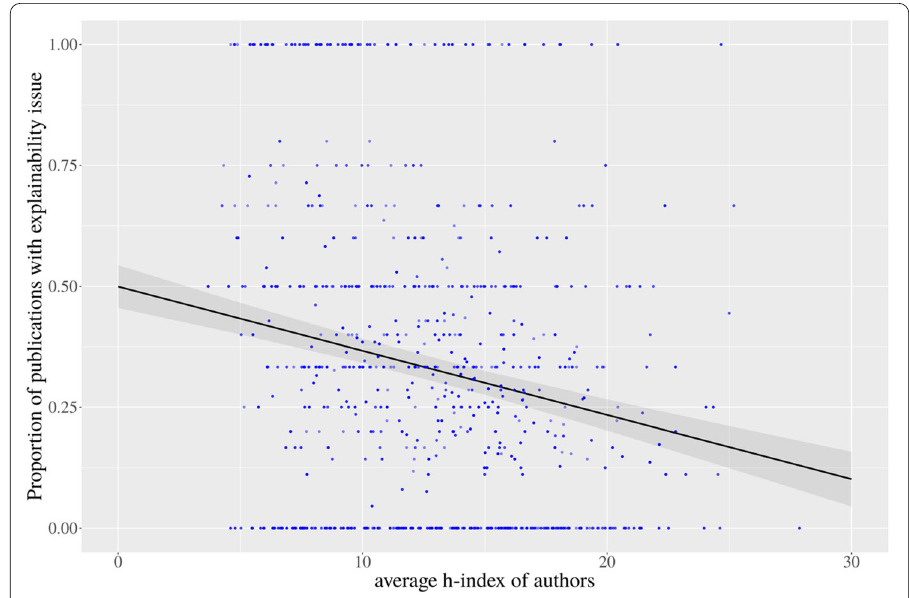
Figure 7 Journal average author h-index’s significant marginal effects on journals’ proportion of publications with explainability